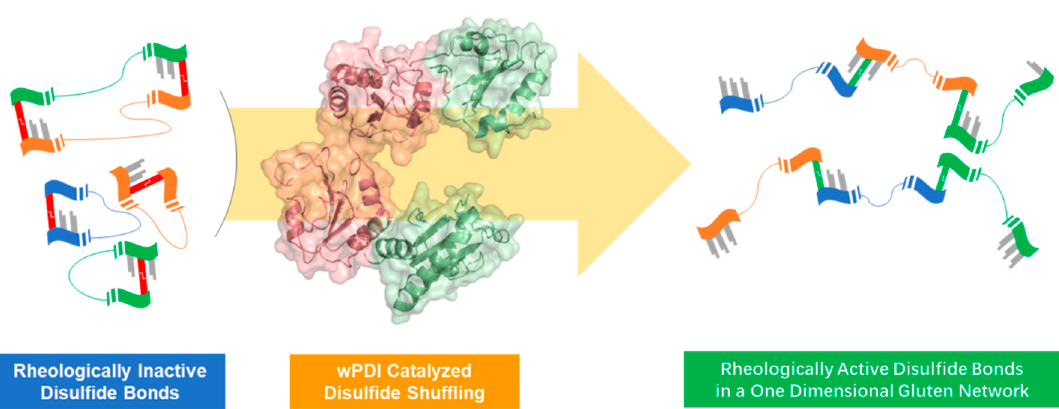
Figure 5. Proposed mechanism of wPDI-catalyzed glutenin macropolymer (GMP) formation. The rheologically inactive disulfide bonds were reduced by wPDI and the active ones were oxidized in between the N- and C- terminals of glutenin subunits to form the gluten network. Left and right: green, orange, and blue ribbons represent different gluten peptides. Grey, red, and green sticks represent free sulfhydryl, rheologically inactive, and active disulfide bonds, respectively. Middle: simulated structure of wPDI, salmon represents its b and b ′ domain and pale green represents the a and a ′ domain.